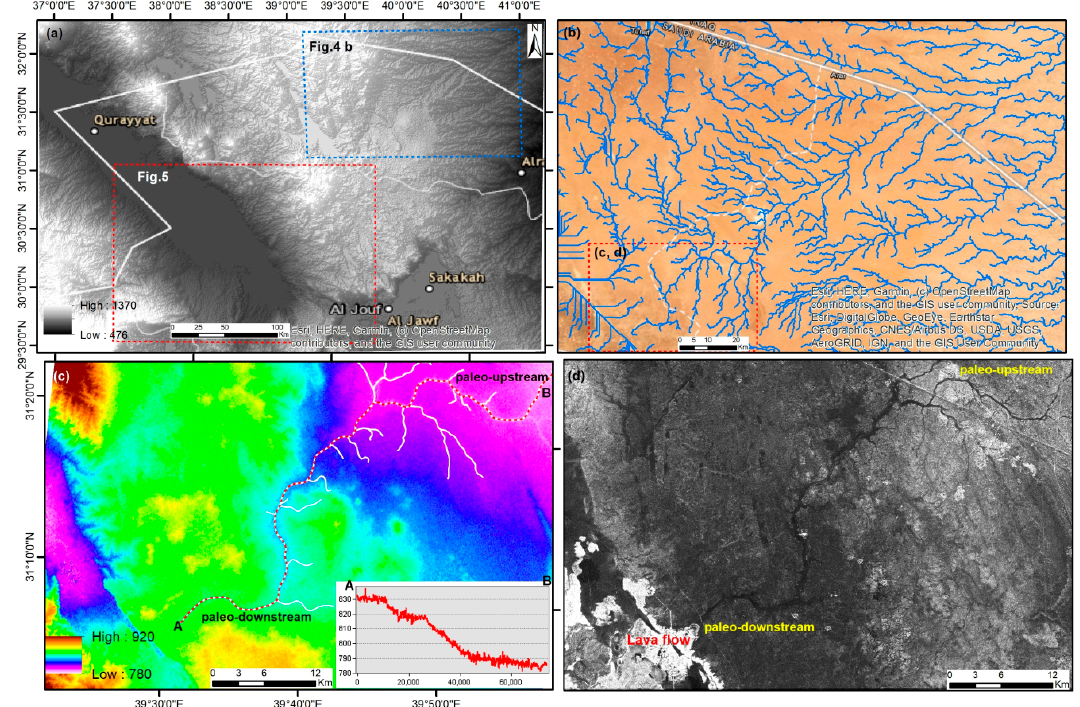
Figure 4. Drainage reversal in the vicinity of Al Jouf (this location is referenced in Figure 1). ( a ) Hill ‐ shade relief of SRTM DEM (90 m) of the Al Jouf area; the blue polygon is explained in Figure 4b, while the red polygon refers to Figure 5. The hilly area in the upper center is composed of several steep cliffs and depressions. ( b ) Extracted stream networks from SRTM, at a resolution of 90 m, for Wadi Sirhan, based on Geo ‐ Eye data. ( c ) SRTM with 30 m resolution of the studied wadi, for the area in the red box in Figure 4b, overlaid with the digitized stream network derived from ALOS/PALSAR. The longitudinal profile (A ‐ B) is indicated with a dashed red line; the profile reveals the northeastward tilt from paleo ‐ downstream to paleo ‐ upstream. ( d ) ALOS/PALSAR of the same area in (c) presenting evidence of drainage reversal with the lower stream flowing toward the southwest. The wide course of the upper stream and presence of a wide dendritic pattern to the east imply drainage reversal. Moreover, the upper stream tributaries are not deflected close to the main channel and still have obtuse angles. Also noteworthy is that the paleoflow direction was to the southwest, which then changed to the northeast because of volcanic activity in the southwest corner of this Figure 4c.